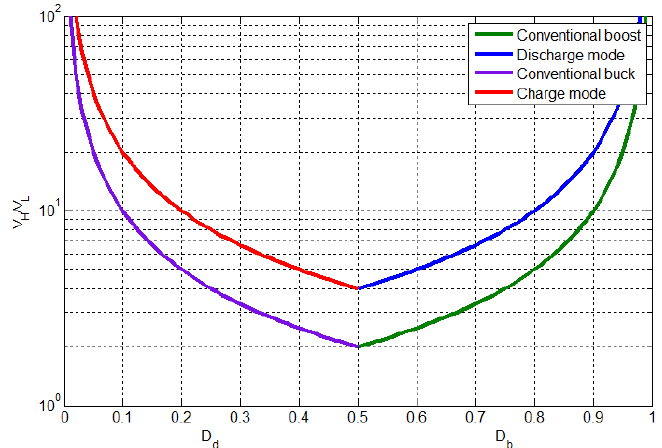
Figure 9. Voltage conversion ratio characteristic of the conventional buck, boost, and the proposed converter for charge and discharge operations